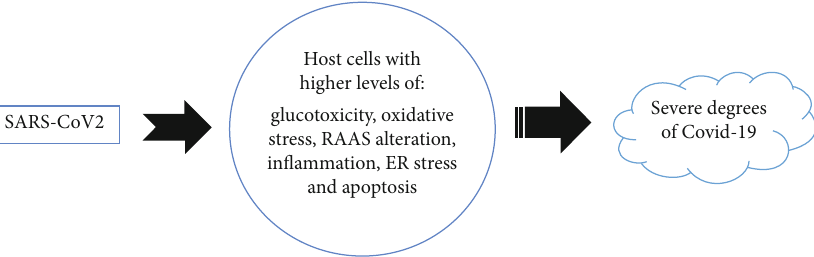
Figure 1: Schematic picture of our hypothesis on the mechanisms by which diabetes intensi fi es COVID-19